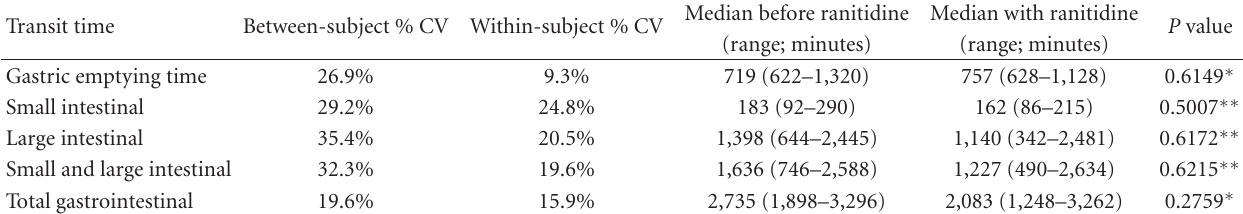
Figure 2: A representative WMC system recording from a healthy dog prior to treatment with ranitidine. The pH trace is shown in green, the pressure trace in red, and the temperature trace in blue. Gastric emptying is indicated by a rapid and sustained increase in pH (a) at 12 hours and 21 minutes, assumed passage of the WMC from the small intestine to the large intestine is represented by the onset of a gradual pH decrease and a change in the character of the pressure trace (b) at 15 hours and 14 minutes, and body exit of the WMC is marked by a sharp decrease in temperature (c) at 46 hours and 6 minutes. Table 1: Summary of GI transit times in healthy dogs measured using the WMC system before and during treatment with ranitidine. % CV = coe ffi cient of variation. Between-subject and within-subject coe ffi cients of variation were calculated based on measurements taken prior to treatment with ranitidine. P values are for testing the null hypothesis that transit time does not di ff er among the 4 repetitions (3 before treatment with ranitidine and the 4th during treatment with ranitidine). ∗ : nonparametric data, transit times for the 4 repetitions were compared using a Friedman’s test; ∗∗ : parametric data, transit times for the 4 repetitions were compared using a repeated measures